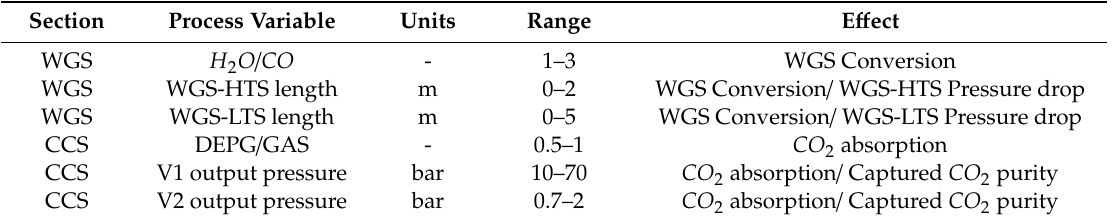
Table 3. Process variables